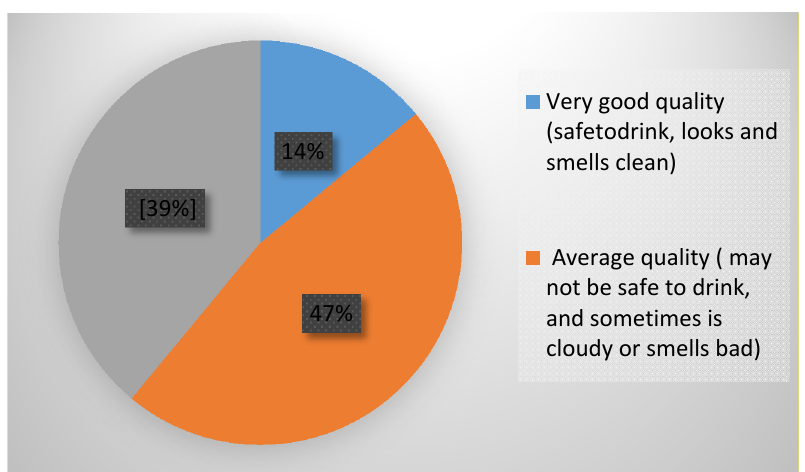
Figure 2. Baseline perception of water quality by households.